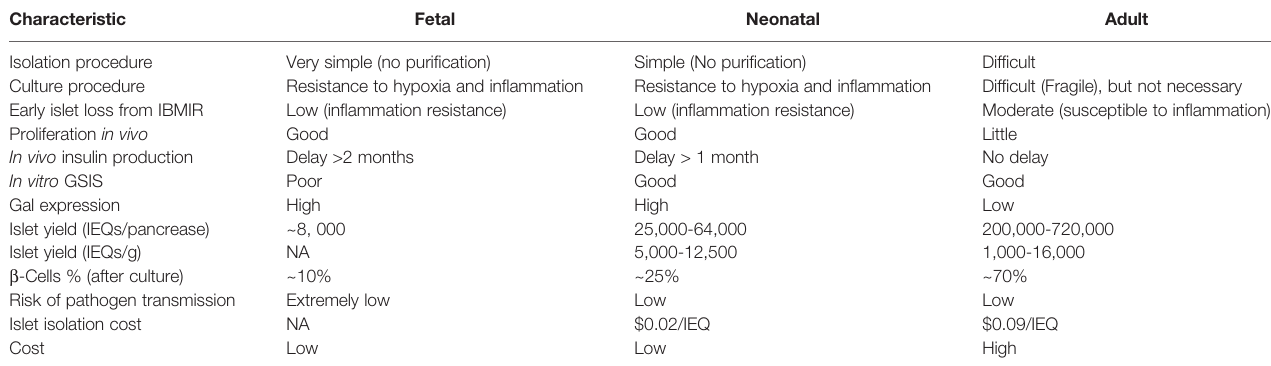
TABLE 1 | Characteristics of islets in pigs of different